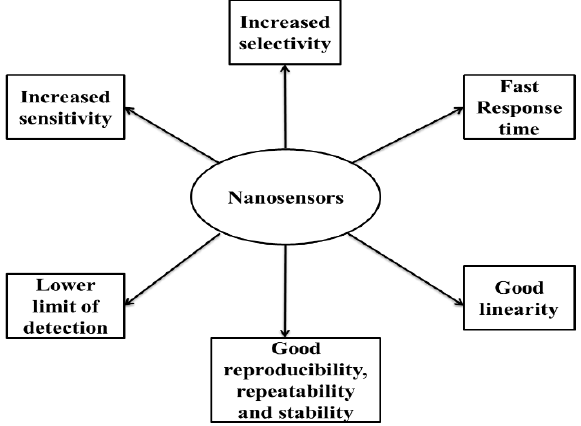
Figure 1. Key performance parameters of nanosensors.